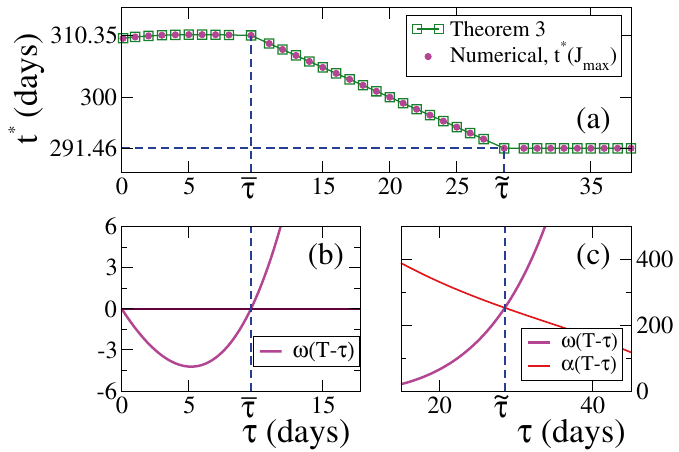
Figure 7. ( a ) Optimal initial time t ∗ vs strict quarantine length τ for κ = 10 − 5 and w ( 0 ) > 0 . ( b ) and ( c ) Graphical determination of the times τ and ˜ τ , respectively, which define the three regions for the different behaviours of t ∗ . The parameters are γ = 0.1 , σ f = 2.2 , σ s = 0.3 , σ m = 1.5 and T = 320 . The initial condition corresponds to x ( 0 ) = 1 − 10 − 6 , y ( 0 ) = 10 − 6 . The optimum time for the region τ > ˜ τ ≃ 28.54 is ˜ t ≃ 291.46 , while t ∗ has a slight dependence on τ for τ ≤ τ ≃ 9.65